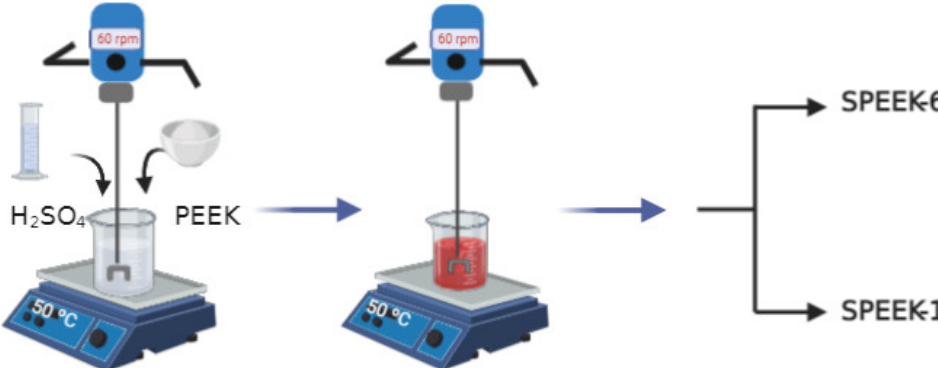
Figure 1. Preparation of a sulfonated poly(ether ether ketone) (SPEEK) polymeric solution.